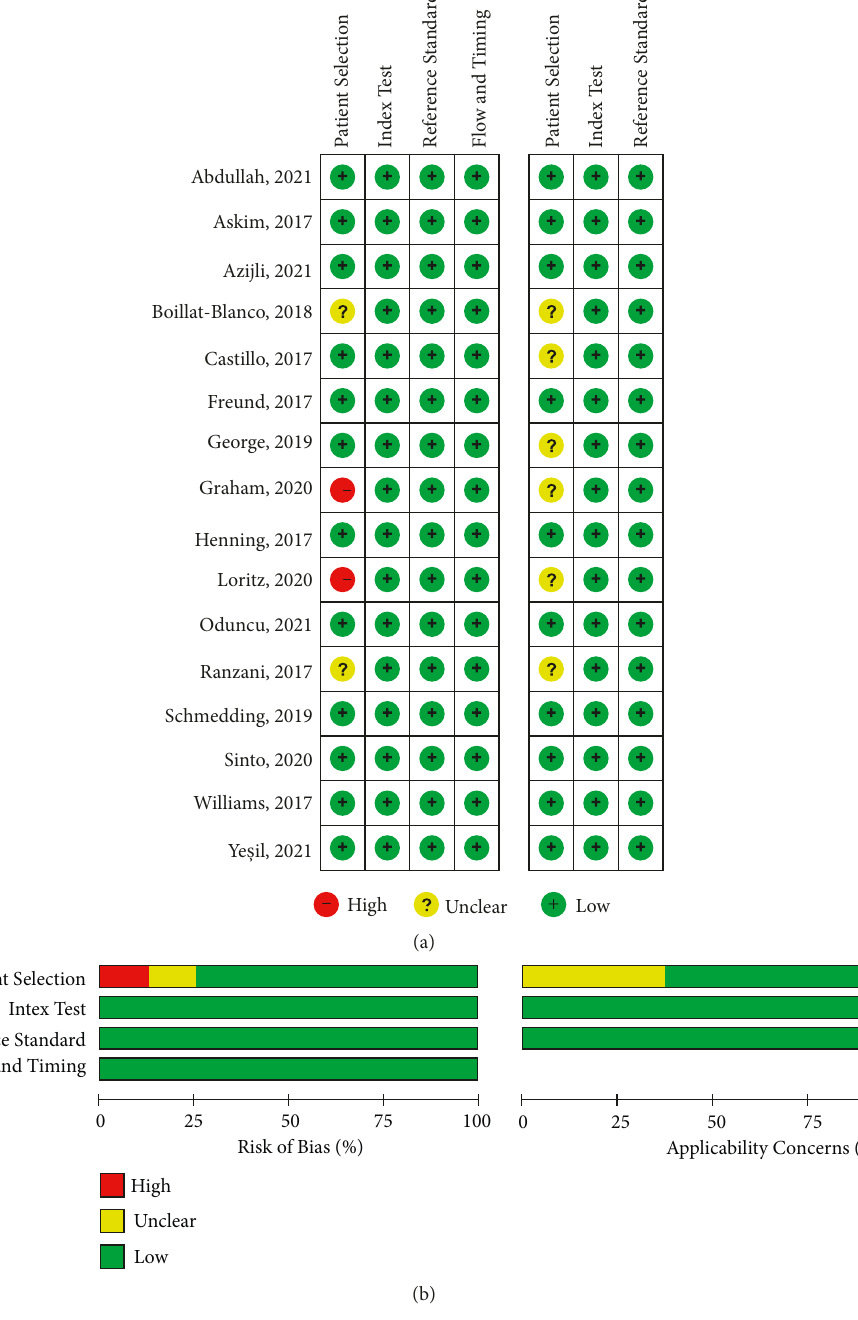
Figure 2: Risk of bias and applicability concerns of the included